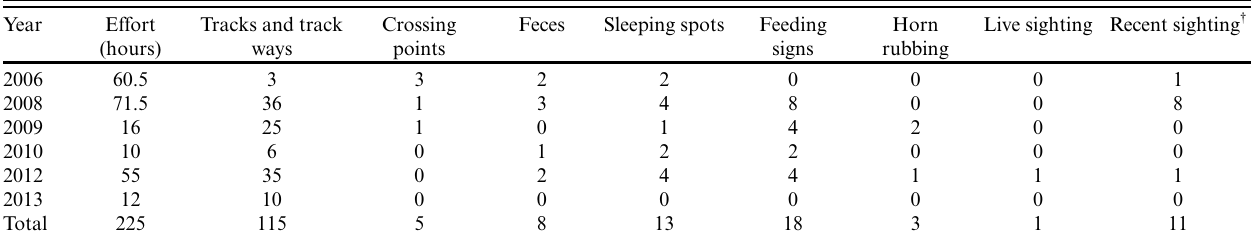
Table 3 . Summary of secondary evidence of sitatunga gathered during hunter-aided surveys 2006-2013. Year Effort Tracks and track Crossing Feces Sleeping spots Feeding (hours) ways points